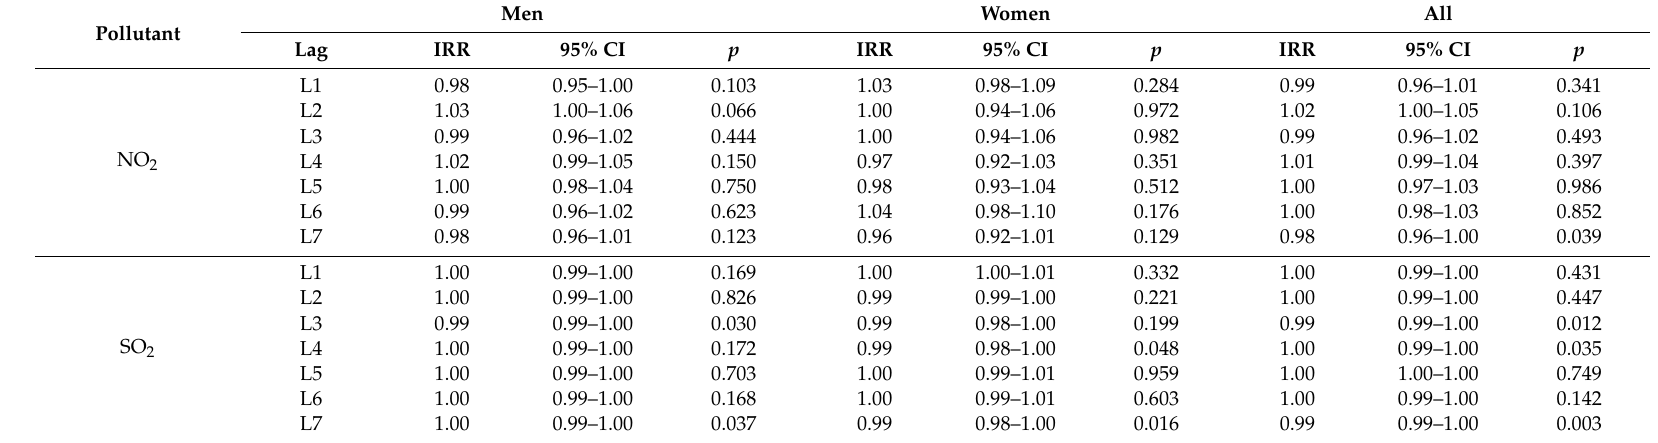
Table 4. Poisson conditional regression models for lagged pollutant e ff ects on daily suicides among men and women in Mexico City,